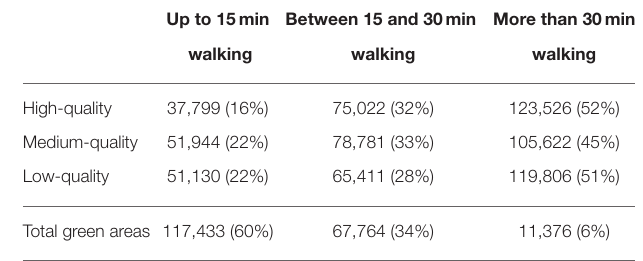
TABLE 5 | Population with access to urban green spaces in Chillán, with quality levels obtained from the survey. Up to 15min Between 15 and 30min More than 30min walking by foot by foot